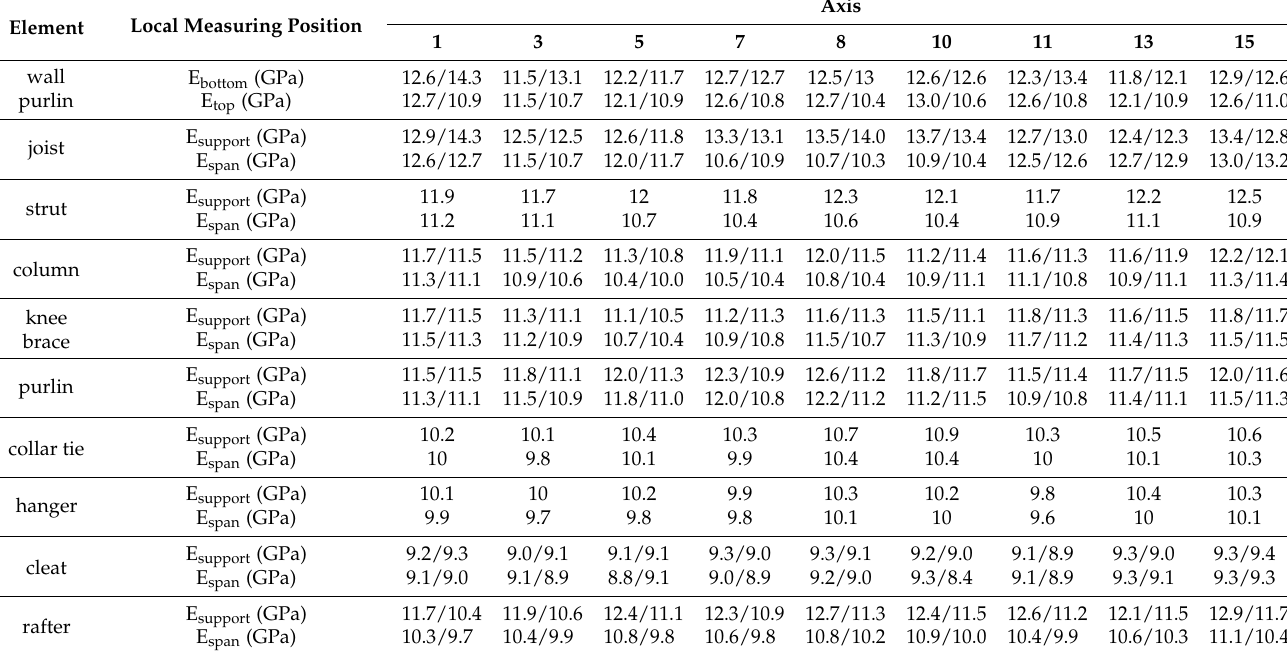
Table 2. Dynamic MOE (parallel to the grain) measurements